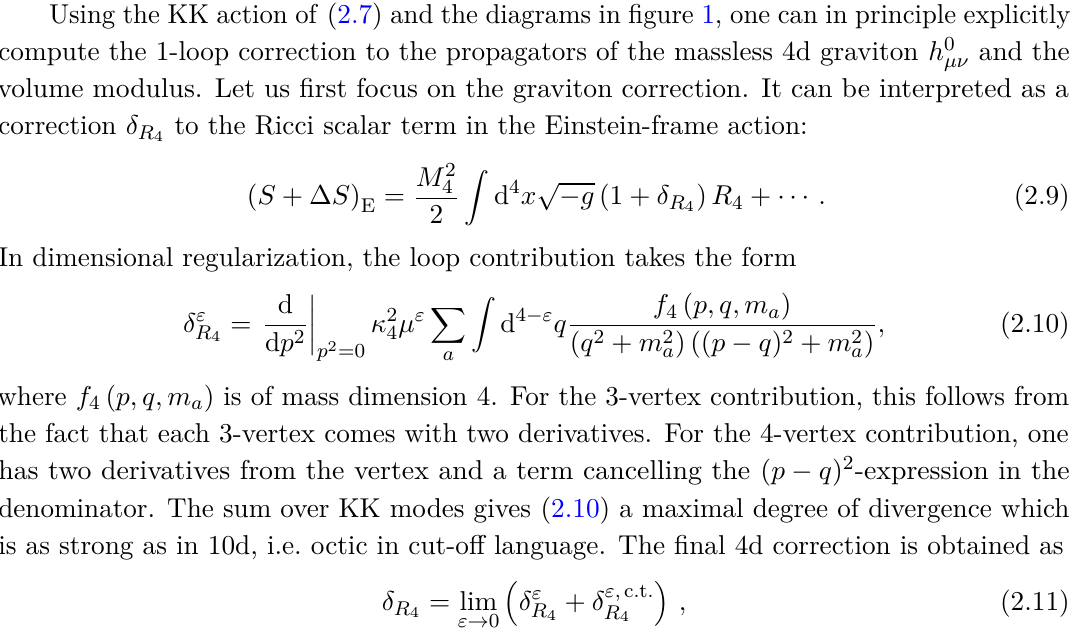
. The field χ a 4